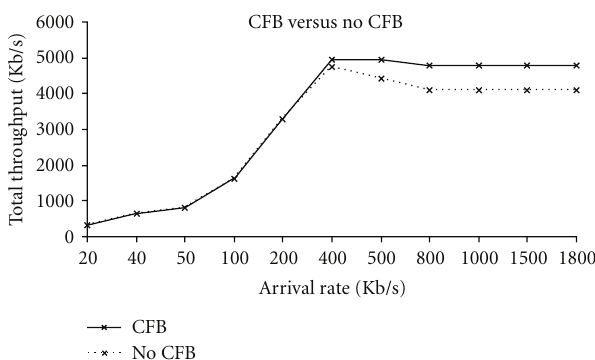
Figure 4: E ff ect of CFB on the total achievable throughput.